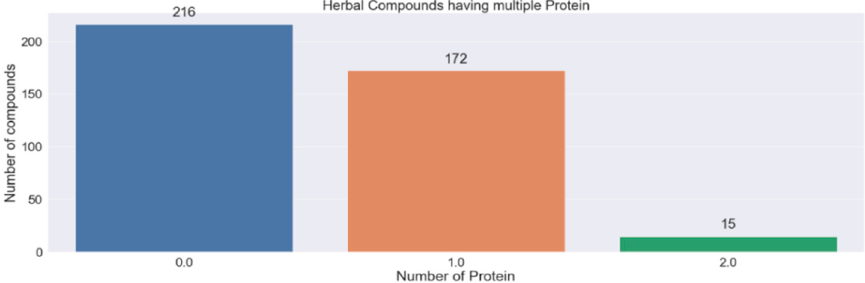
Figure 2. Details of the number of herbal compounds that interact with the protein set predicted by SAE-DNN with PubChem fingerprint datasets.